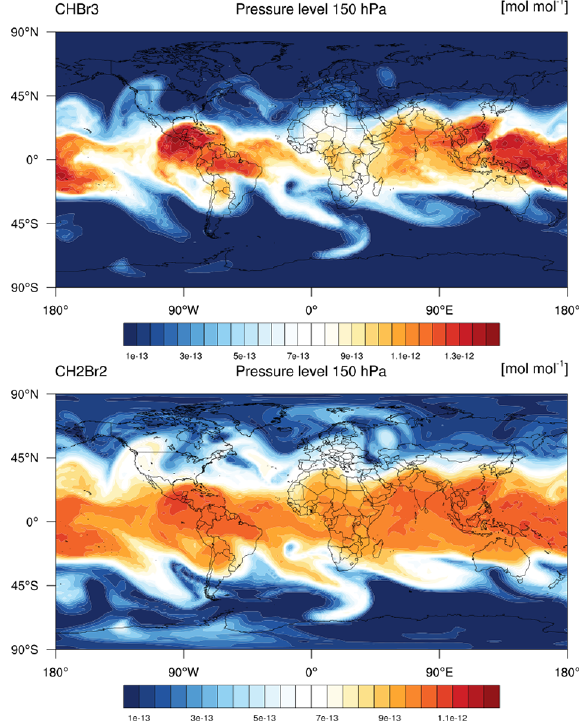
Figure 5. Simulated distribution of CHBr 3 (top) and CH 2 Br 2 (bot- tom) volume mixing ratio at 150hPa at 1 October 2012. Please note the different color scales.